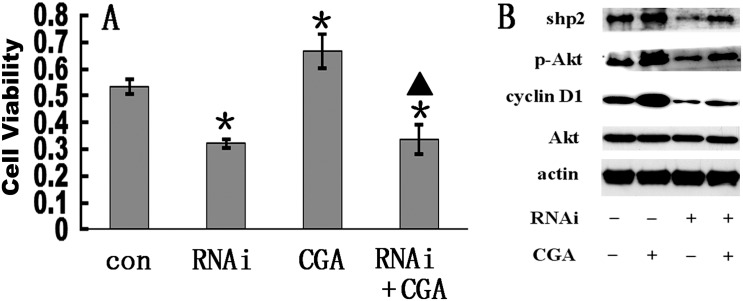
Effect of Shp2/PI3K/Akt/cyclin D1 pathway inhibition on CGA-induced upregulation of osteoblast differentiation in rat BMSCs.(A) Viability in cells exposed to 10 μM Shp2 RNAi and 10 μM CGA. Each column represents the mean ± SD of the optical density values. *p < 0.01 vs. control (con) group. ▲ p < 0.01 vs. RNAi group. (B) Western blots of Shp2, p-Akt, cyclin D1, and Akt expression in cells exposed (+) to 10 μM CGA and RNAi. β-actin was used as the loading control.